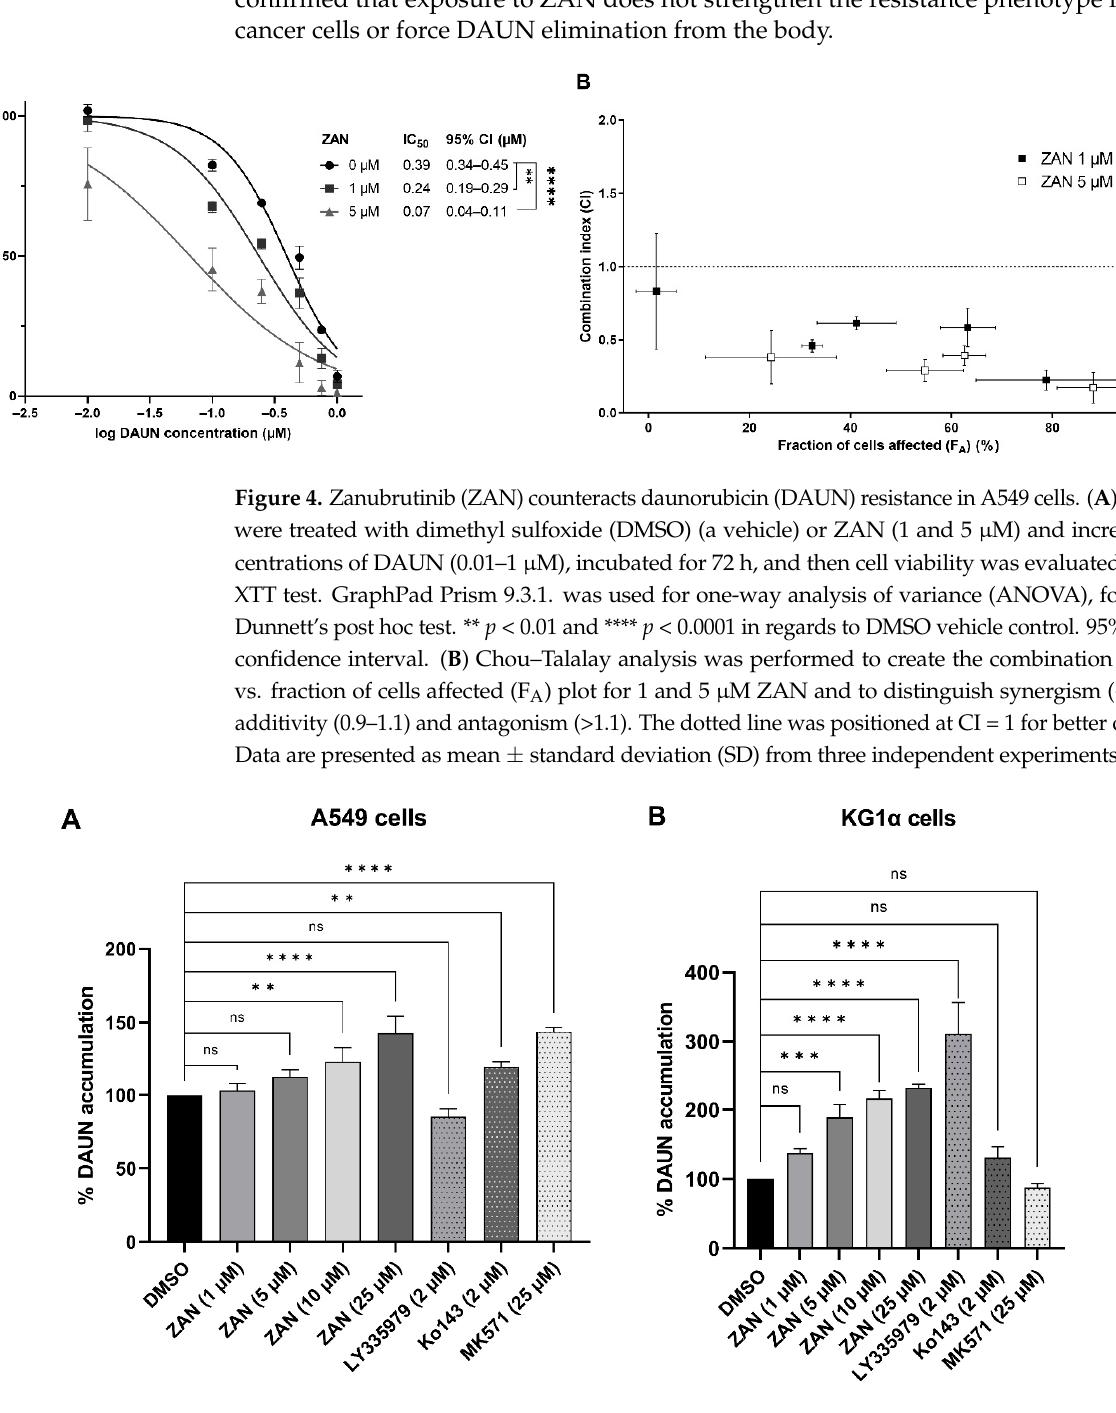
Figure 5. Flow cytometry analysis of daunorubicin (DAUN) accumulation in A549 ( A ) and KG1 α cells ( B ). A549 and KG1 α cells were preincubated with zanubrutinib (ZAN) (1, 5, 10, and 25 µM) or selective inhibitors of ABC transporters: LY335979 (inhibitor of ABCB1), Ko143 (inhibitor of ABCG2), or MK571 (inhibitor of ABCC1). After preincubation, 2 µM (A549) or 1 µM DAUN (KG1 α ) were added to the cells. The bar graphs represent the DAUN accumulation in % relative to the dimethyl sulfoxide (DMSO) vehicle control. Data were analysed by one-way analysis of variance (ANOVA), followed by Dunnett’s post hoc test; ns = non-significant, ** p < 0.01, *** p < 0.001, and **** p < 0.0001. Data are presented as mean ± standard deviation (SD) from three independent experiments.